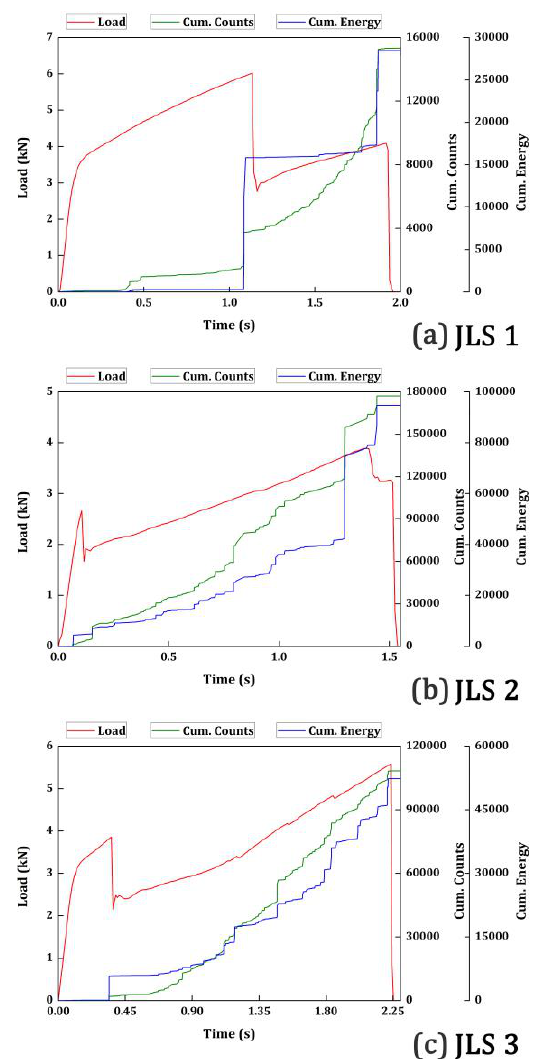
Figure 5. Load, cumulative counts, cumulative energy vs. time: ( a ) JLS 1; ( b ) JLS 2; ( c )JLS 3.